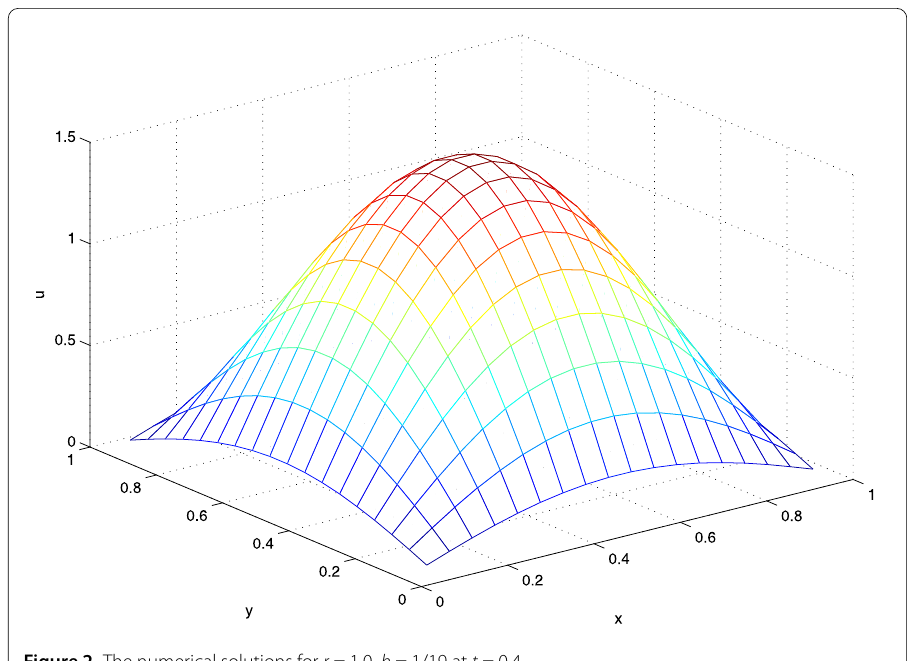
Figure 2 The numerical solutions for r = 1.0, h = 1/19 at t = 0.4